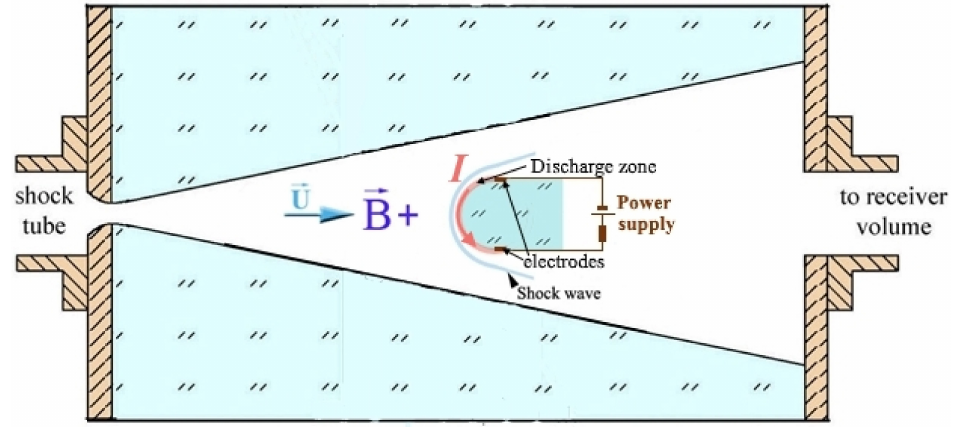
Figure 14. Scheme of the arrangement of the aerodynamic body in the nozzle in the case of supersonic flow, with the closing of the gas discharge current according to the two-electrode